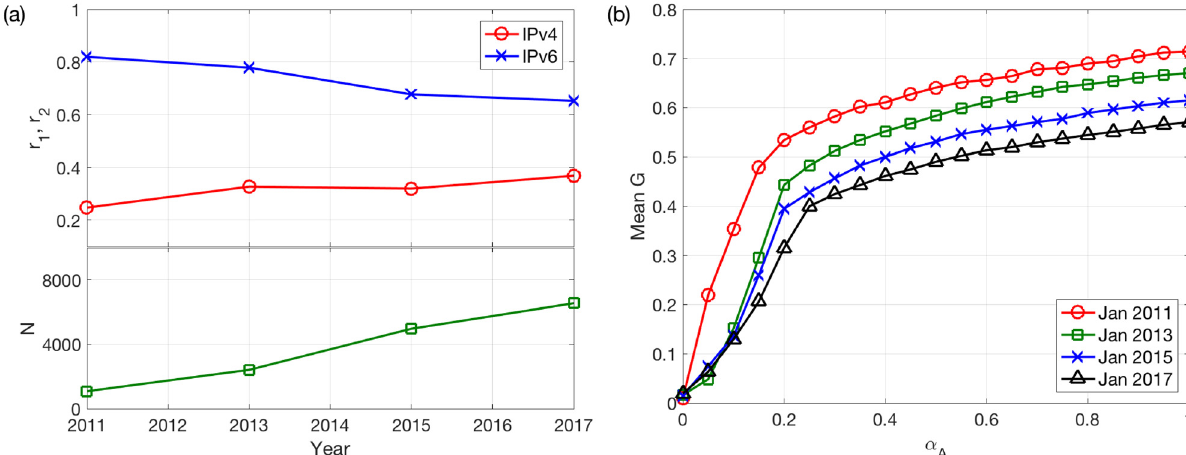
Fig 10. Results on real-world coupled IPv4/IPv6 networks. (a) Fraction of overlapping links, r 1 and r 2 and the system size N in the multiplexIPv4/IPv6 networks in Januaryof different years. N = 1086, 2416, 4974, and 6550, respectively. (b) Mean G as a function of α A in the model with realisticIPv4/IPv6 networks and the SUM rule. Januaryin different years, averagedover M = 30 realizations.